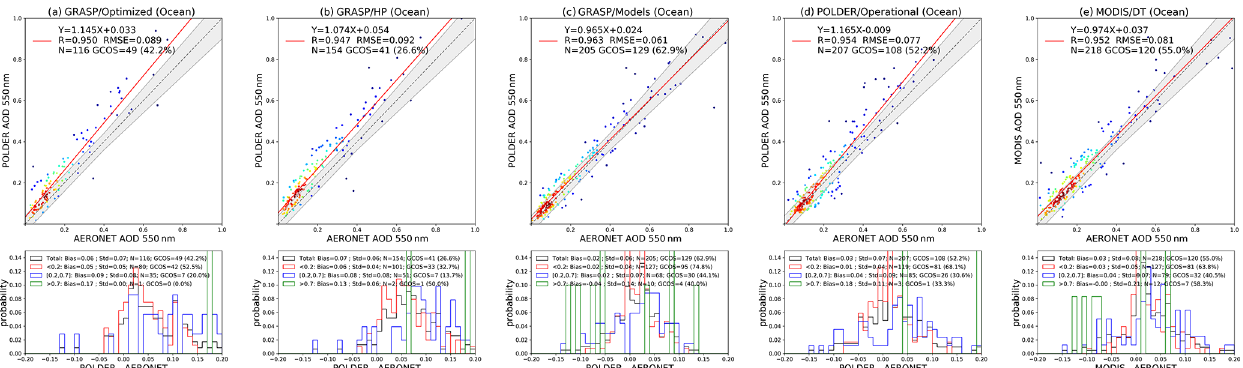
Figure 9. Validation of PARASOL/GRASP, PARASOL/Operational and MODIS/DT AOD at 550nm over ocean in 2008. (a) GRASP/Optimized; (b) GRASP/HP; (c) GRASP/Models; (d) Operational; (e) DT. The gray dashed line and the red solid line are the 1 : 1 reference line and the linear regression line. The gray envelope indicates GCOS requirement: max (0.04 or 0.1AOD). The probability density functions of differences (satellite–AERONET) are present in the lower panel. The black, red, blue and green solid lines indicate all AOD conditions: any AOD, AOD < 0.2, 0.2 ≤ AOD ≤ 0.7 and AOD > 0.7, respectively.